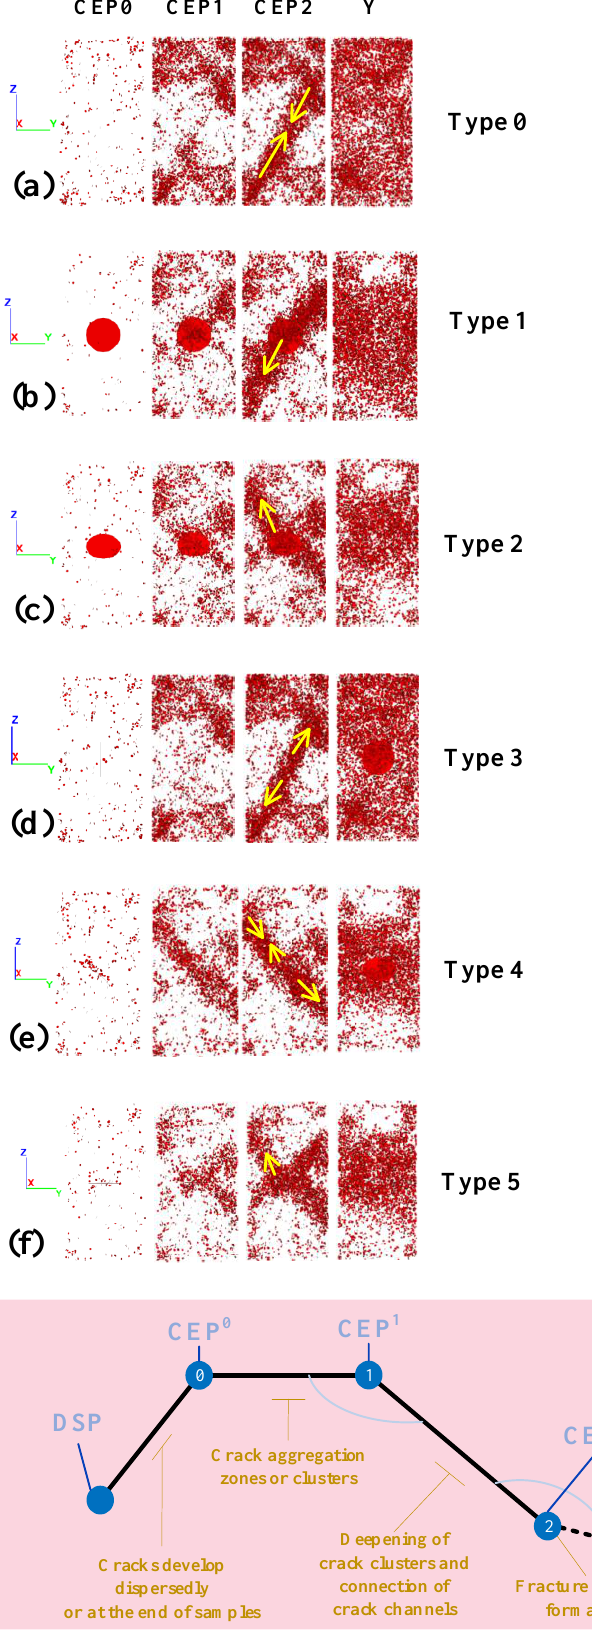
Figure 10. Crack development and evolution process. ( a ) ; ( b ) ; ( c ) ; ( d ) ; ( e ) ; ( g ) .